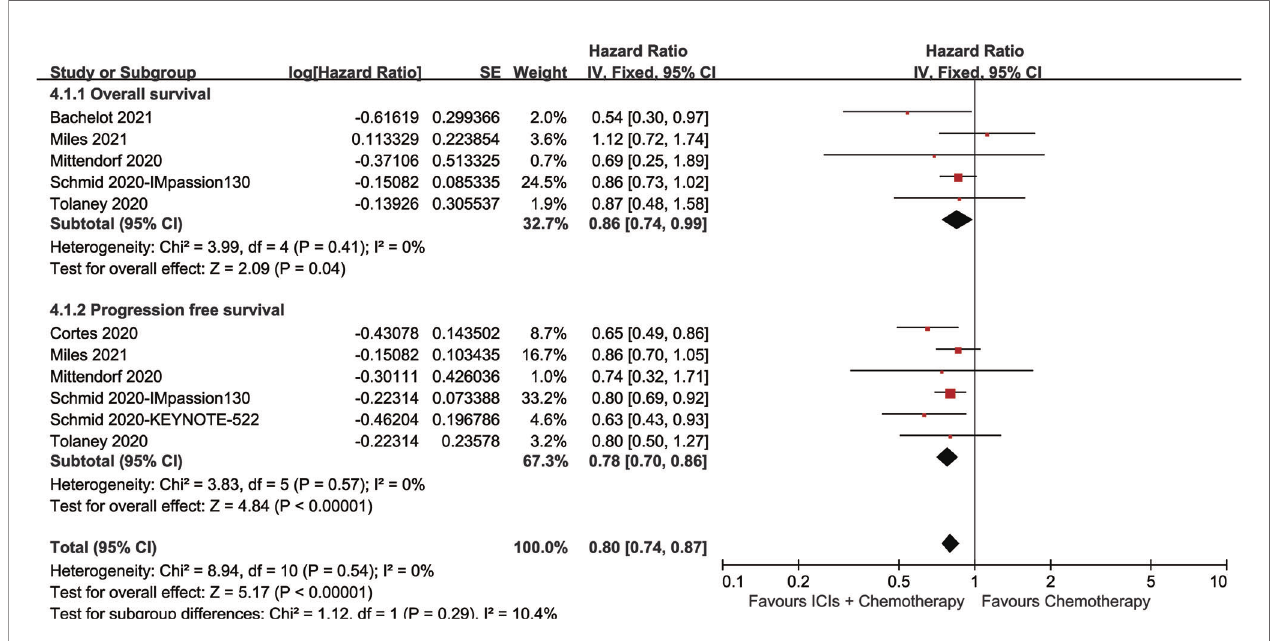
FIGURE 2 | Forest plots of OS and PFS associated with ICIs+Chemotherapy versus Chemotherapy.